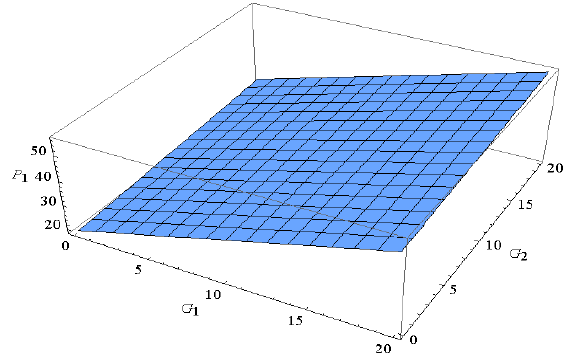
Figure 2. Product optimal price curve over time, under decentralized decision making.